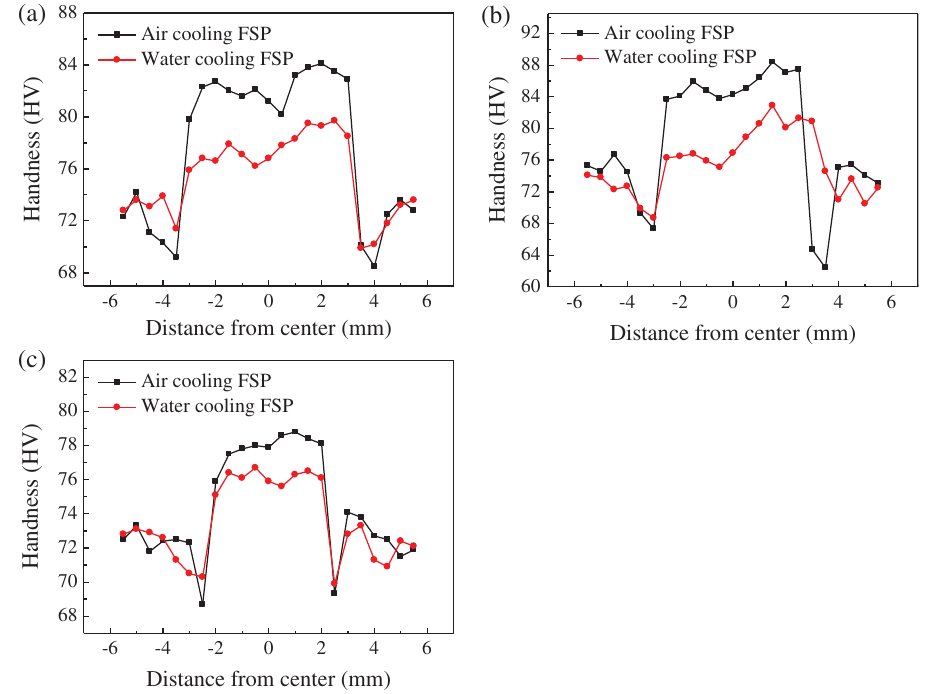
Figure 11: The hardness of processed zone: (a) upper line, (b) middle line and (c) lower